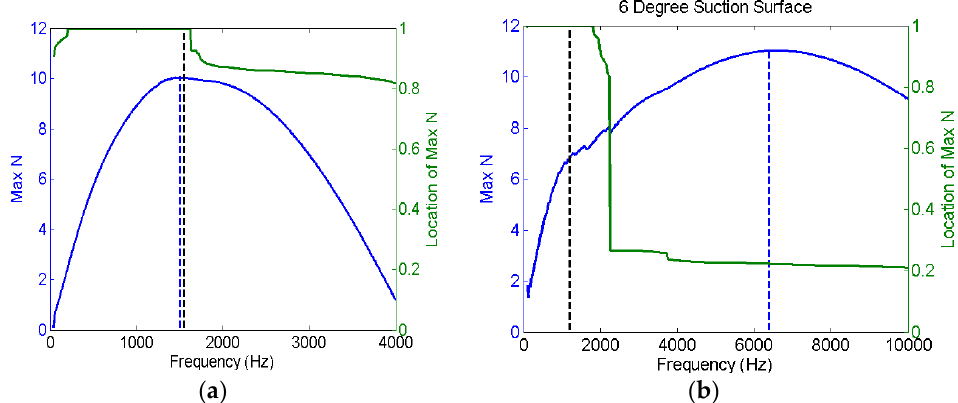
Figure 20. Instability mode amplifications (blue line), location of modal peaks (green line), peak acoustic frequency (dashed black line) for AOA of 0° ( a ) and 6° (suction side) ( b ). [18].